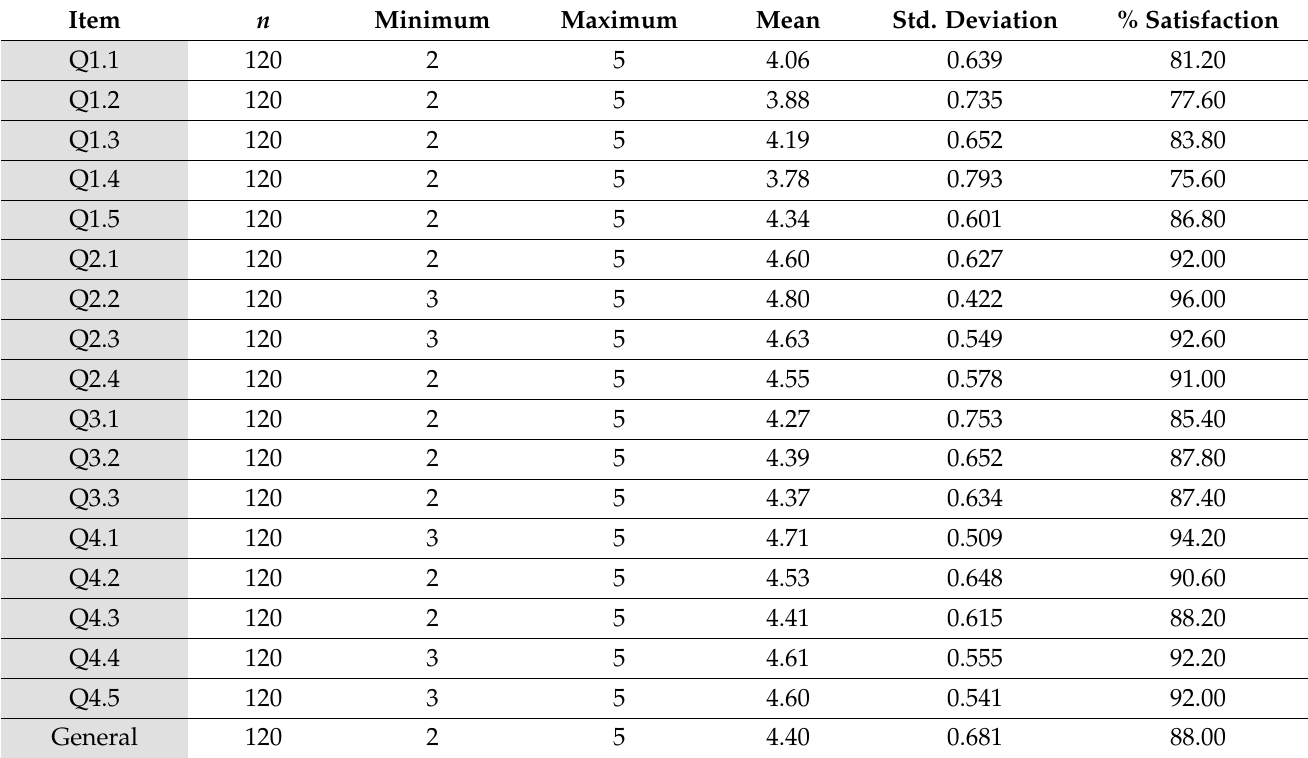
Table 4. Descriptive statistics of 5-point Likert questions and % satisfaction.